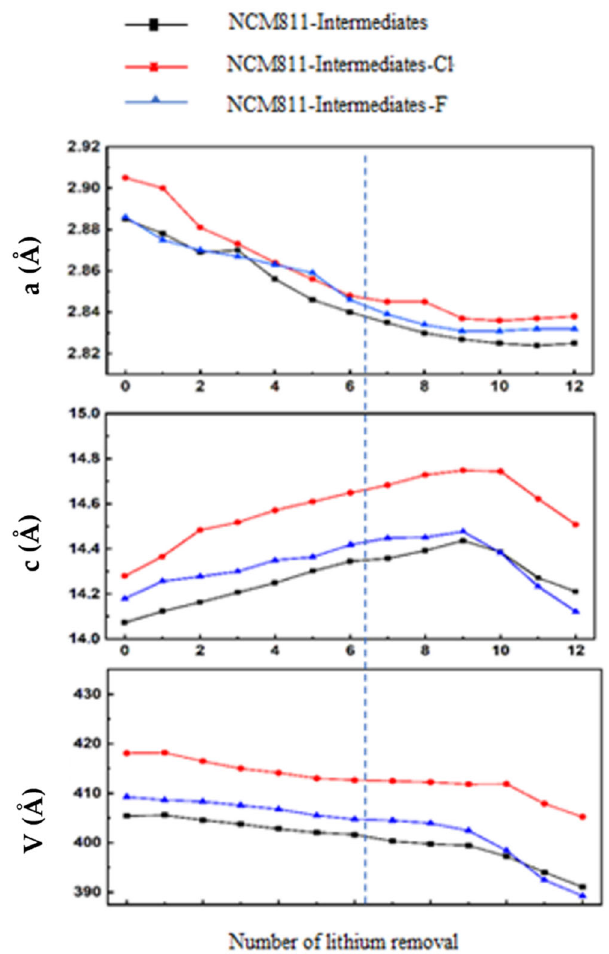
Figure 6. Changes of unit cell parameters during delithiation.